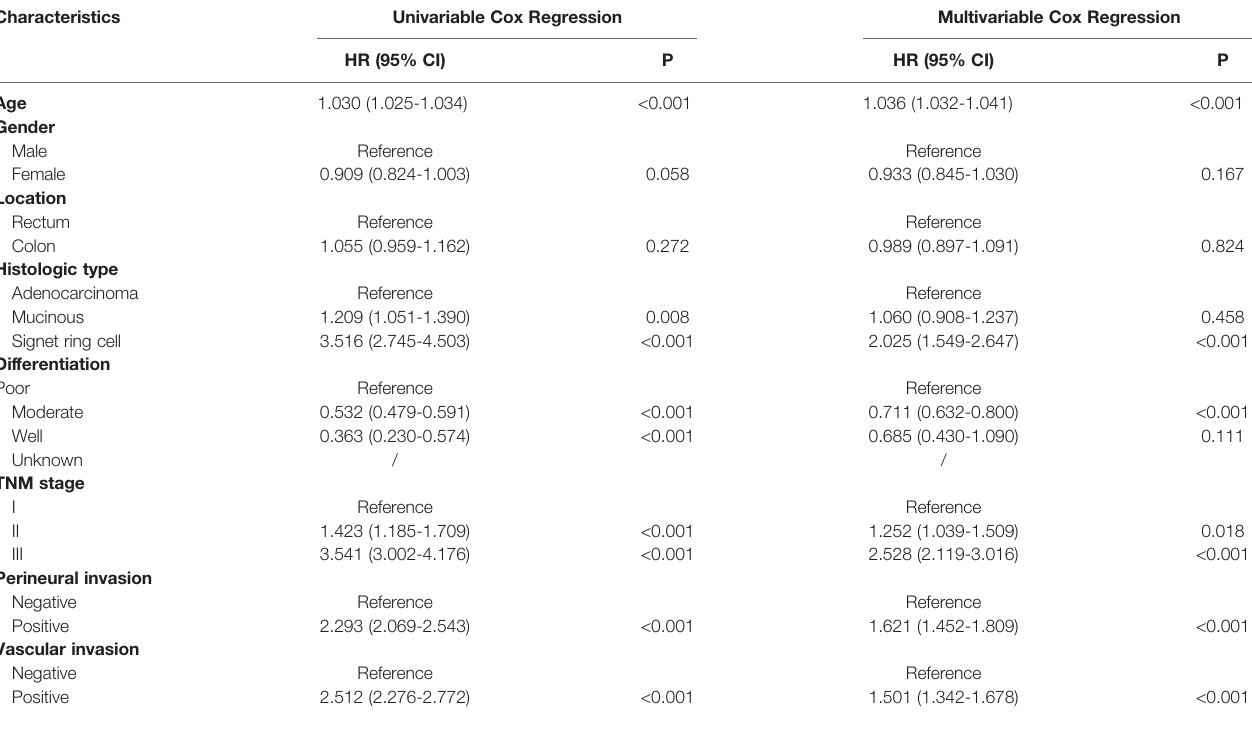
TABLE 3 | Univariable and multivariable Cox regression of overall survival in entire